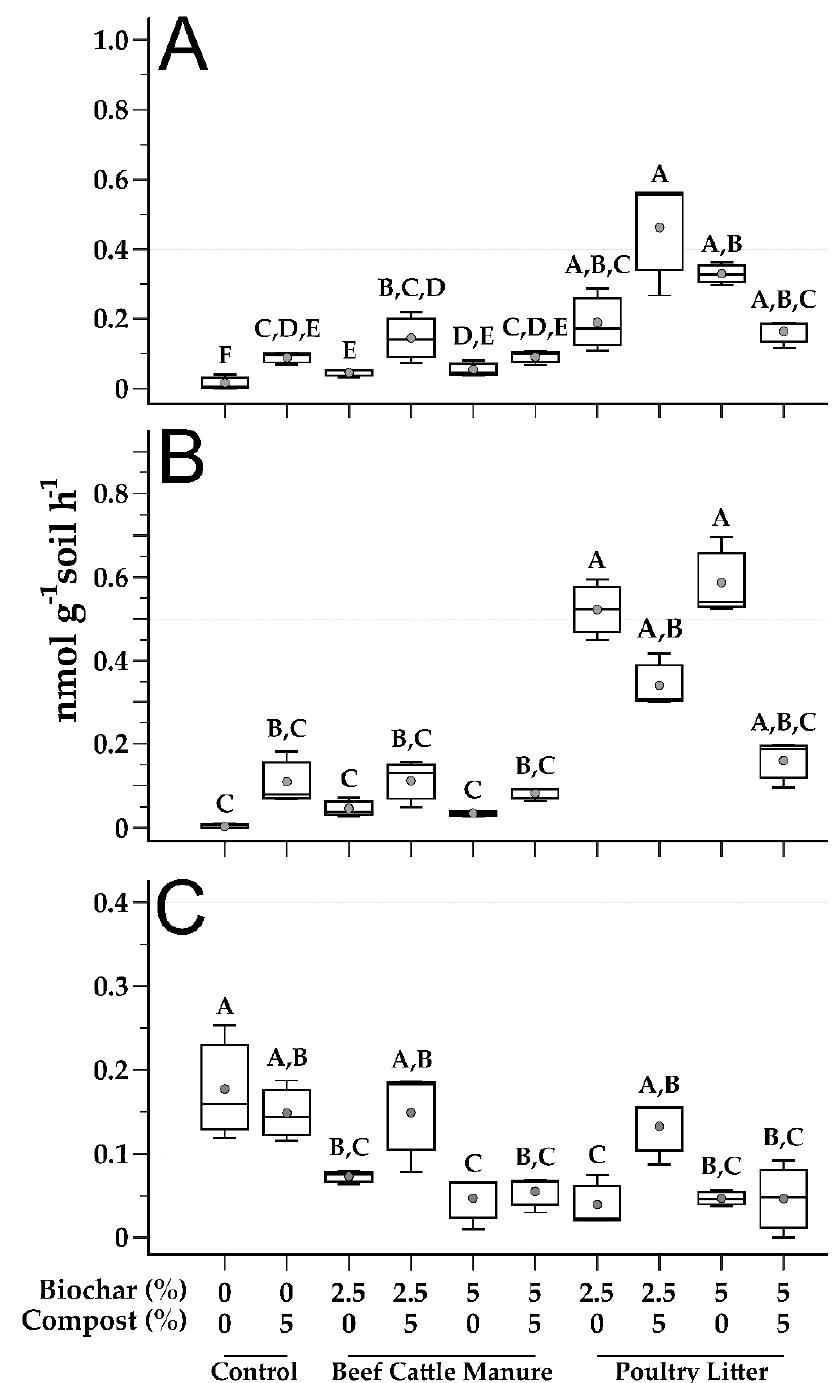
Figure 4. Soil extracellular enzyme activity. Top panel ( A ) is β -glucosidase, middle panel ( B ) is N-acetyl- β - D -glucosaminidase, and bottom panel ( C ) is acid phosphomonoesterase. Vertical axes for each enzyme are not shown on same scale. Gray circles are mean values, top and bottom of boxes are 75th and 25th percentile, respectively, median is center line, and whiskers are range of the data. Treatments that do not share a letter are significantly different ( p < 0.05). Data are presented as untransformed, with statistical analysis based on log-transformed values.